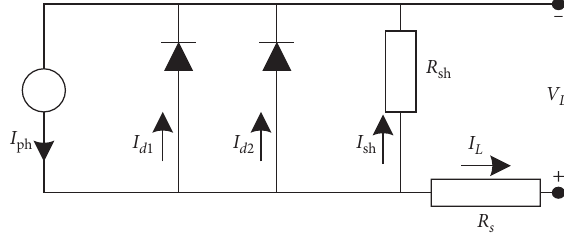
Figure 2: Equivalent circuit diagram of DDM.